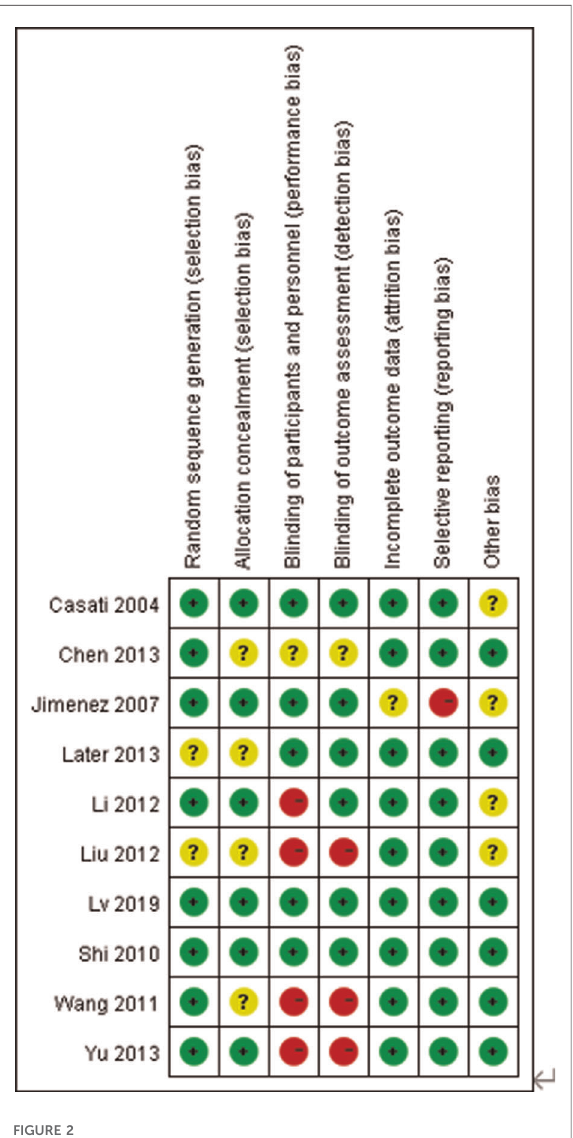
FIGURE 2 Risk-of-bias graph for each included study. Green (+), red ( – ), and yellow (?) circles indicate low, high, and unclear riskof bias,